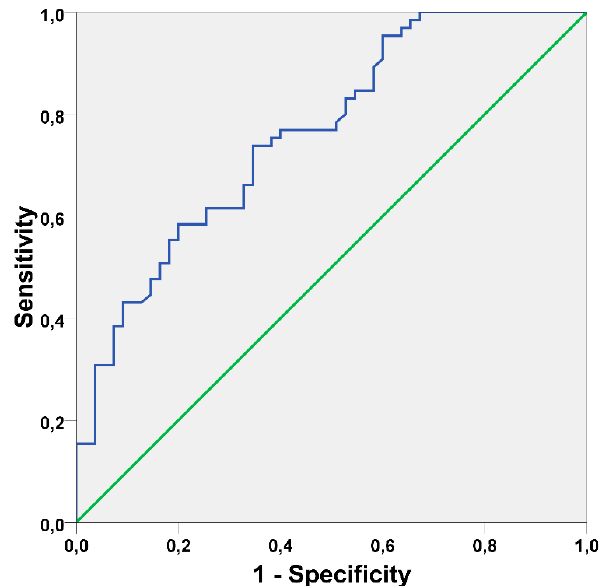
Figure 1. Receiver operating characteristic curve illustrating the performance of the prognostic model on the derivation set (Area under the curve = 0.763 95% CI [0.679; 0.847], standard error = 0.043, p < 0.001).